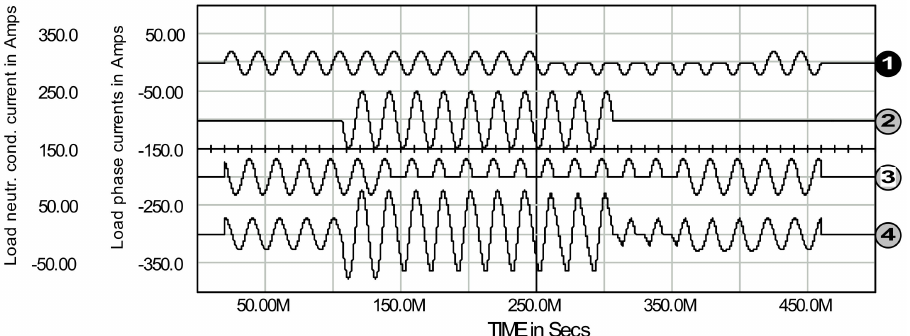
Figure 21. Load phase A, B, and C currents: waveforms 1–3, respectively, and load neutral conductor current: waveform 4.